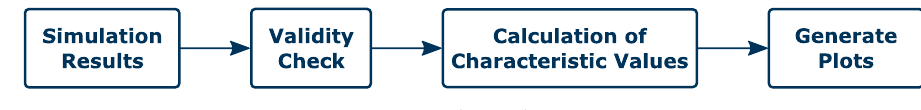
Figure 7. Steps in the evaluation